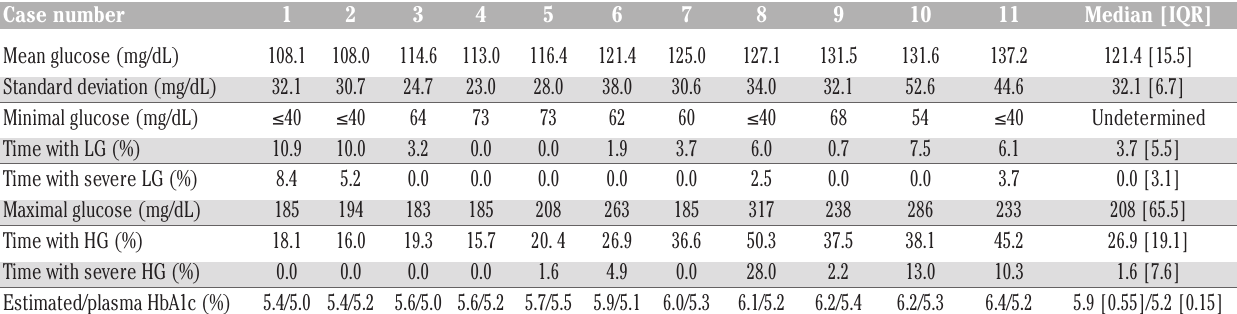
Table 2. Results of continuous glucose